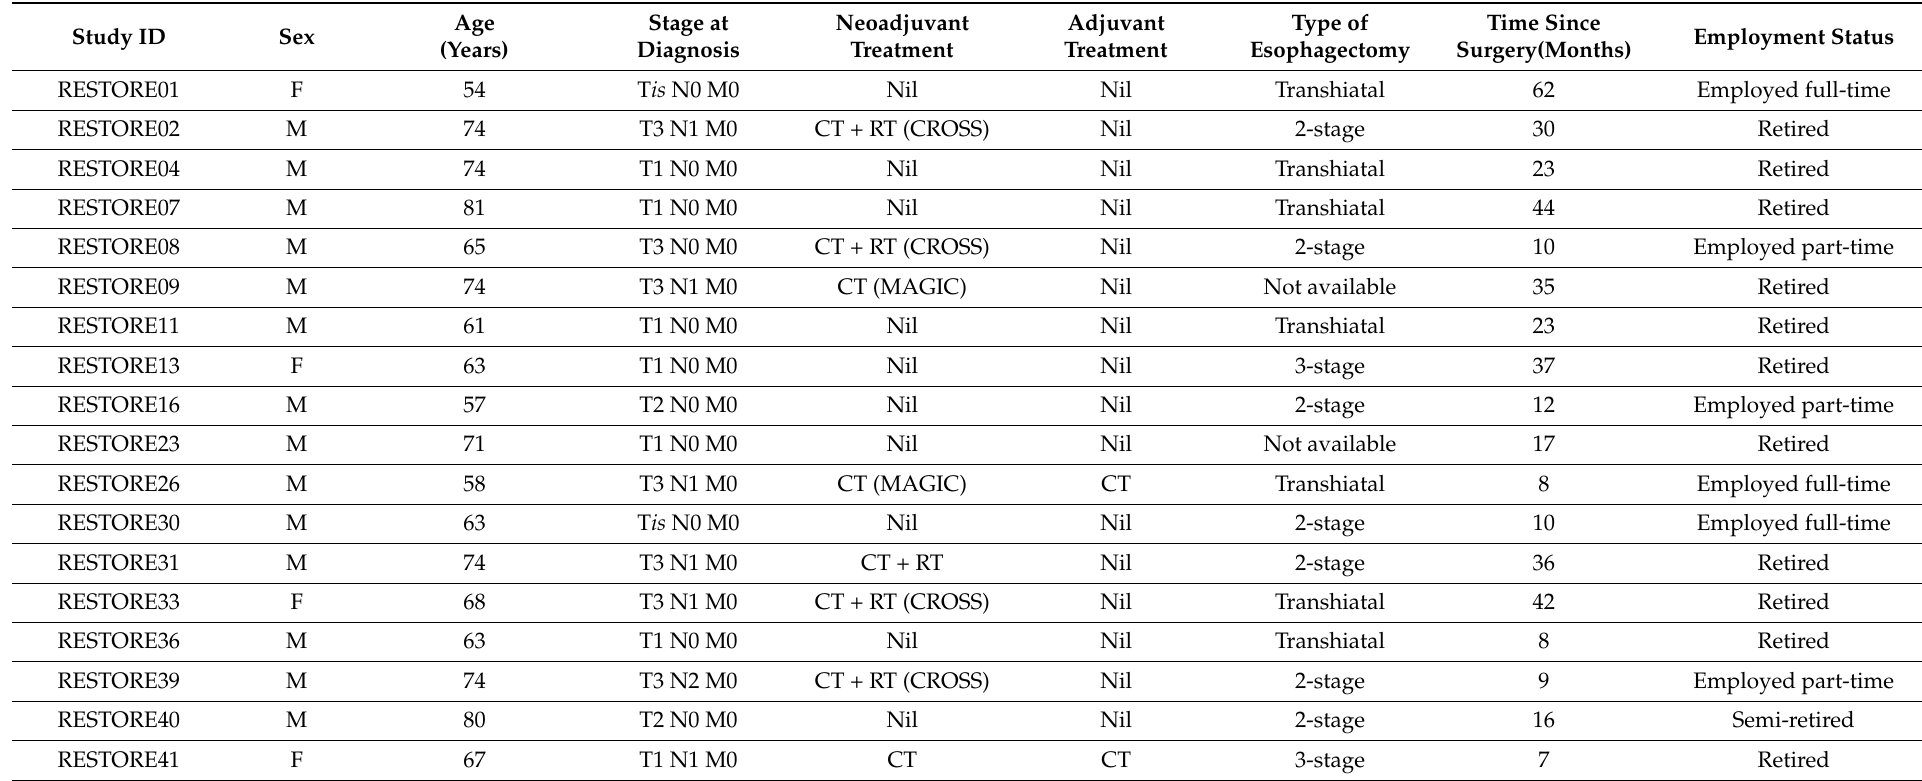
Table 1. Characteristics of 18 esophageal cancer survivors participating in focus